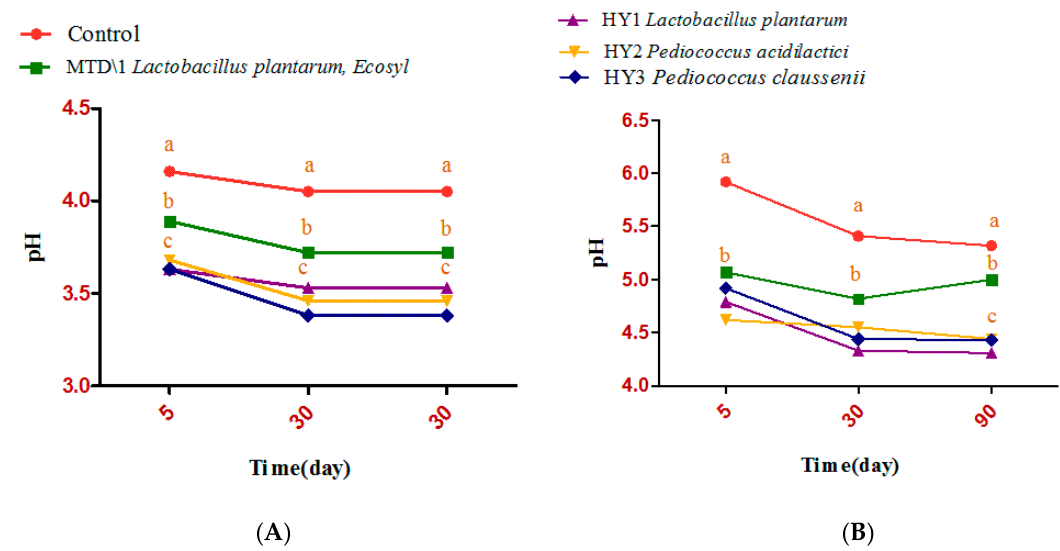
Figure 2. Effect of LAB inoculants on pH dynamics ( A ) sweet sorghum, ( B ) Napier grass silage, during different opening times.